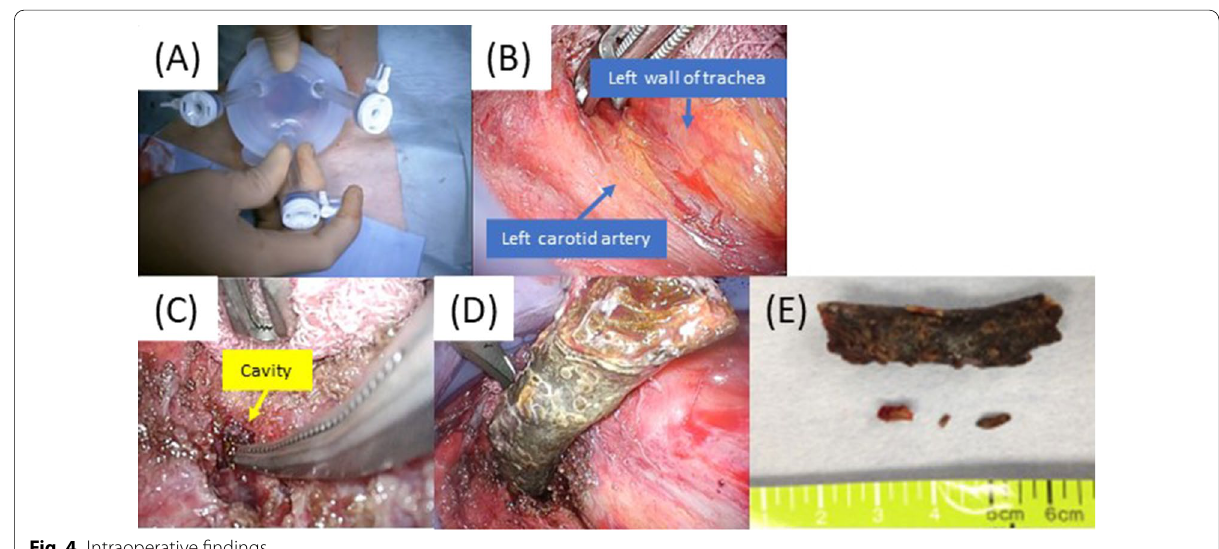
Fig. 4 Intraoperative findings